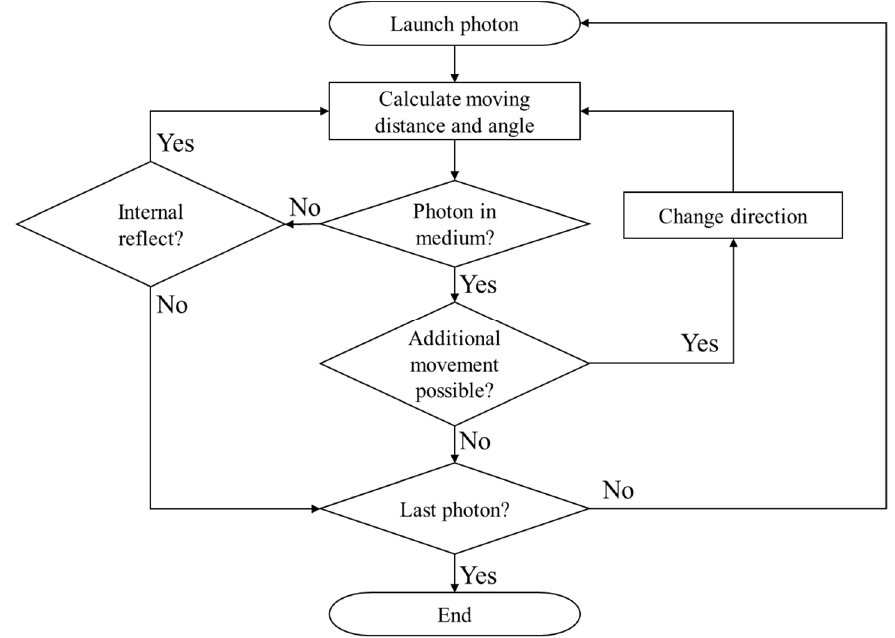
Figure 1. Flow chart of the Monte Carlo method.